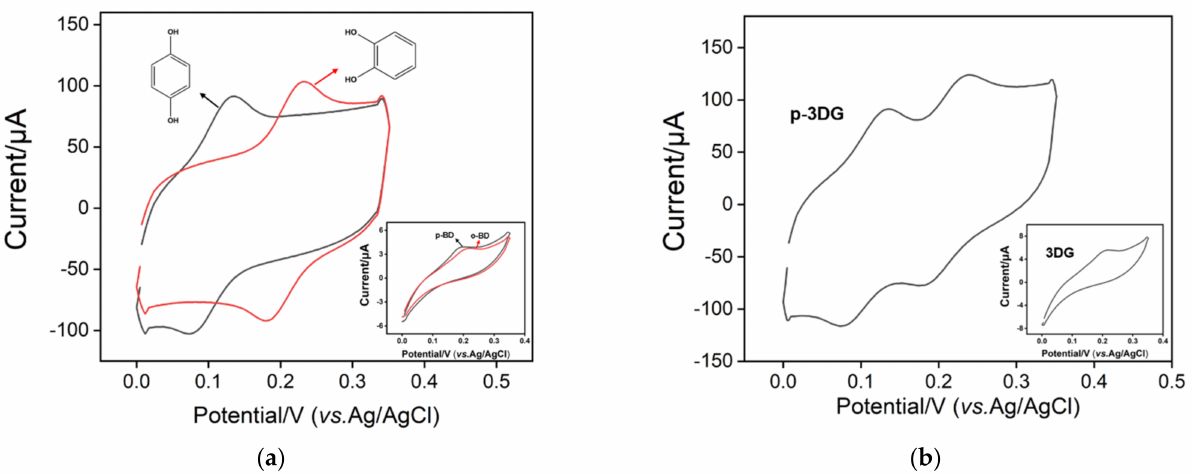
Figure 4. ( a ) Cyclic voltammetry curves of p-BD (50 µ M) or o-BD (50 µ M) on p-3DG or 3DG (inset). ( b ) Cyclic voltammetry curve of mixture of p-BD and o-BD (both 50 µ M) at p-3DG or 3DG (inset) electrode. The electrochemical electrolyte is 0.1 M PBS solution (pH 7). The scan rate was 100